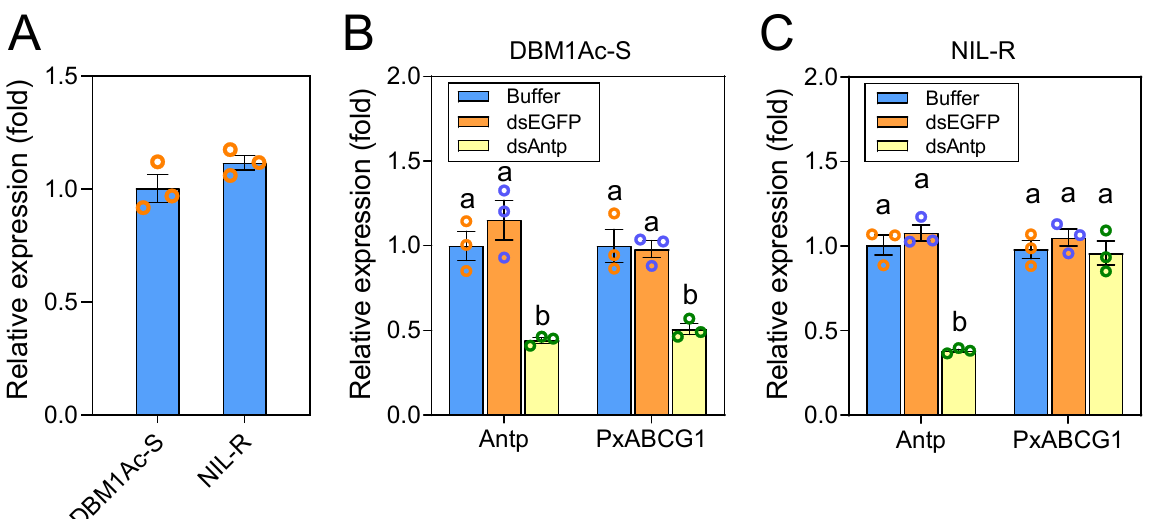
Figure 5. Effect of Antp on PxABCG1 expression in vivo. ( A ) Relative expression of the midgut Antp gene in 4th-instar larvae of the susceptible strain DBM1Ac-S and the resistant strain NIL-R. The RPL32 gene was used as an internal control. The average relative expression level and standard error of the mean (SEM) of three independent replicates are presented. Student’s t-test was used for statistical analysis ( p < 0.05). ( B ) Relative expression of Antp and PxABCG1 in larvae of the susceptible strain DBM1Ac-S at 48 h post injection with buffer, dsEGFP, or dsAntp. The expression levels of Antp or PxABCG1 in the control larvae injected with buffer were set as 1. Different letters among groups indicate statistically significant differences ( p < 0.05; Duncan’s test; n = 3). Different letters on the bars indicate significant differences. ( C ) Relative expression of Antp and PxABCG1 in larvae of the resistant strain NIL-R at 48 h post injection with buffer, dsEGFP, or dsAntp. Different letters on the bars indicate significant